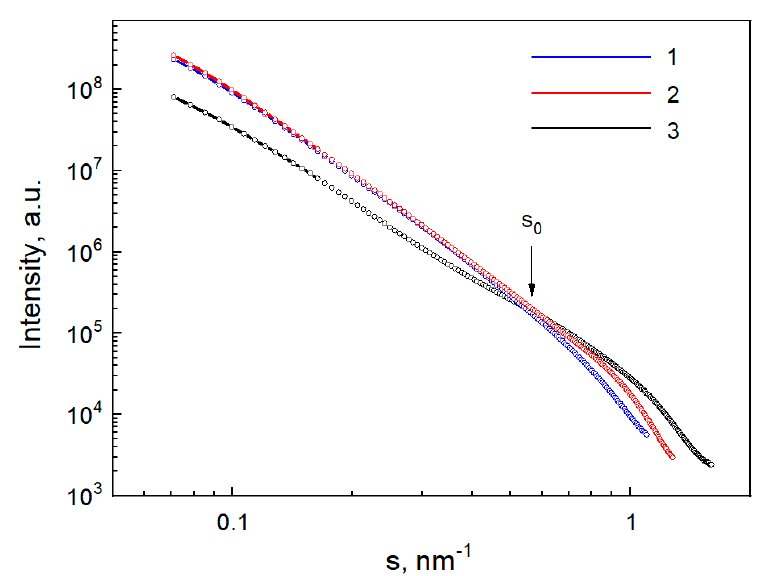
Figure 7. Curves of intensity of X-ray scattering by samples NC1_10 (1), NC1_5 (2), NC2 (3) after collimation correction for the height of the detector receiving slit.